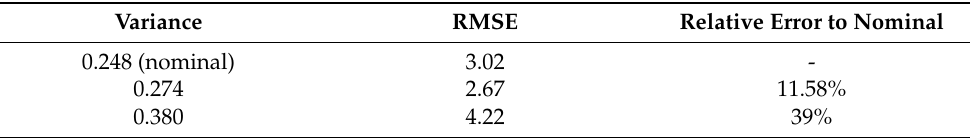
Table 5. Comparison of RMSE for different Gaussian random noises